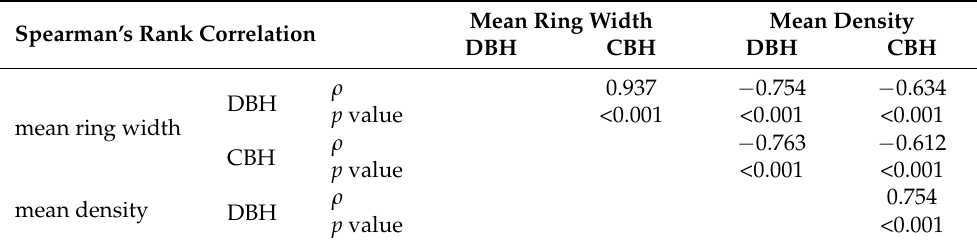
Table 2. Spearman’s rank correlation ( ρ ) and corresponding p value for the relationship